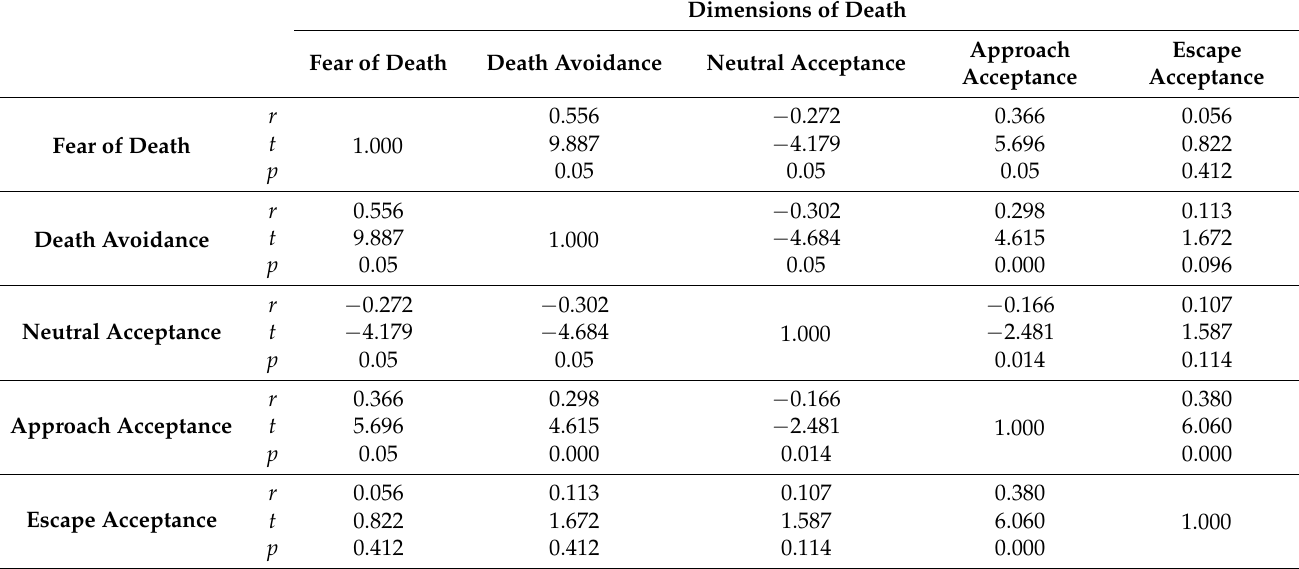
Table 3. Relationship between variables regarding attitudes to